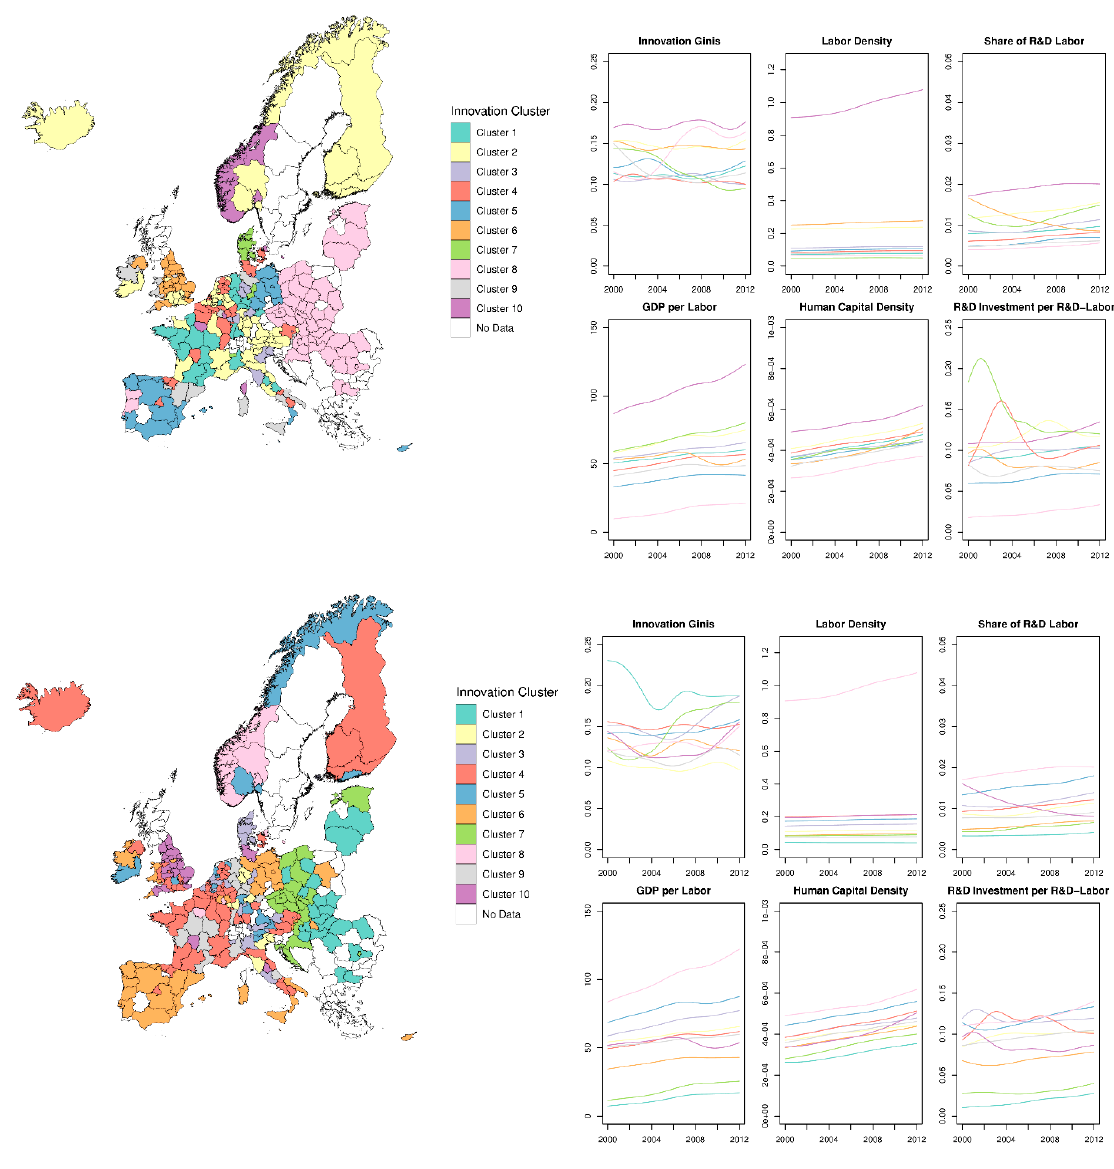
Figure 3. Results of the mixture model-based multivariate functional clustering algorithm. Rows: IPC classes G and H (G: ‘physics’; H: ‘electricity’). Columns: left: Spatial cluster mapping, right: classes G and H (G: ‘physics’; H: ‘electricity’). Columns: left : Spatial cluster mapping, right : Temporal Temporal cluster dynamics. Source: Own calculations. cluster dynamics. Source: Own